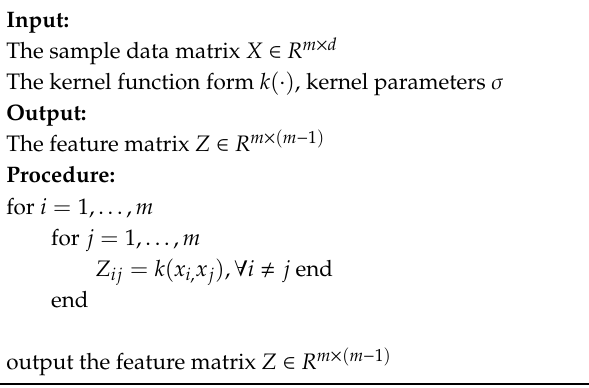
Algorithm 1. The FSE